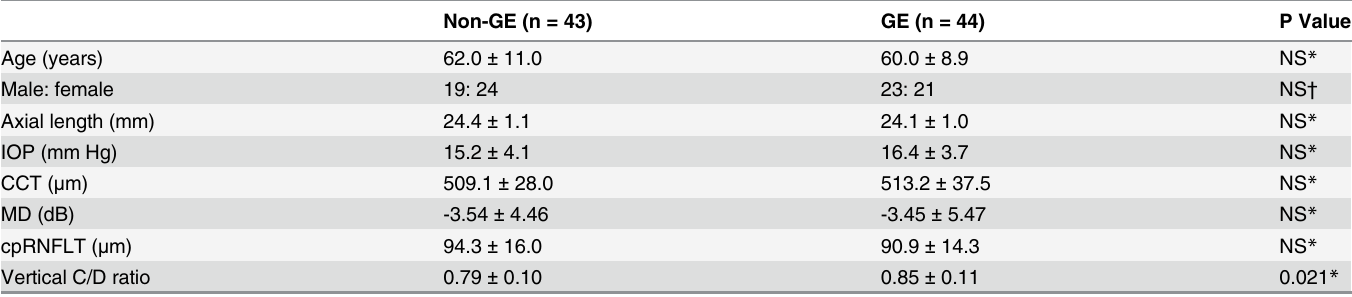
Table 3. Clinical characteristics of patients with non-GE and GE